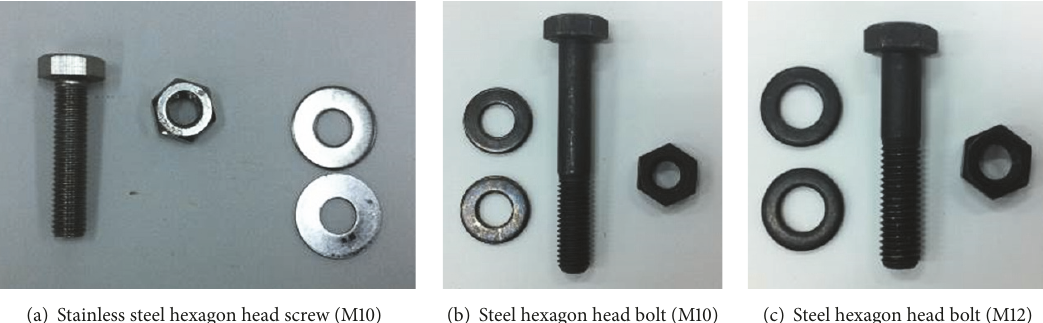
Figure 7: Type of bolt, nut, and washer used in the